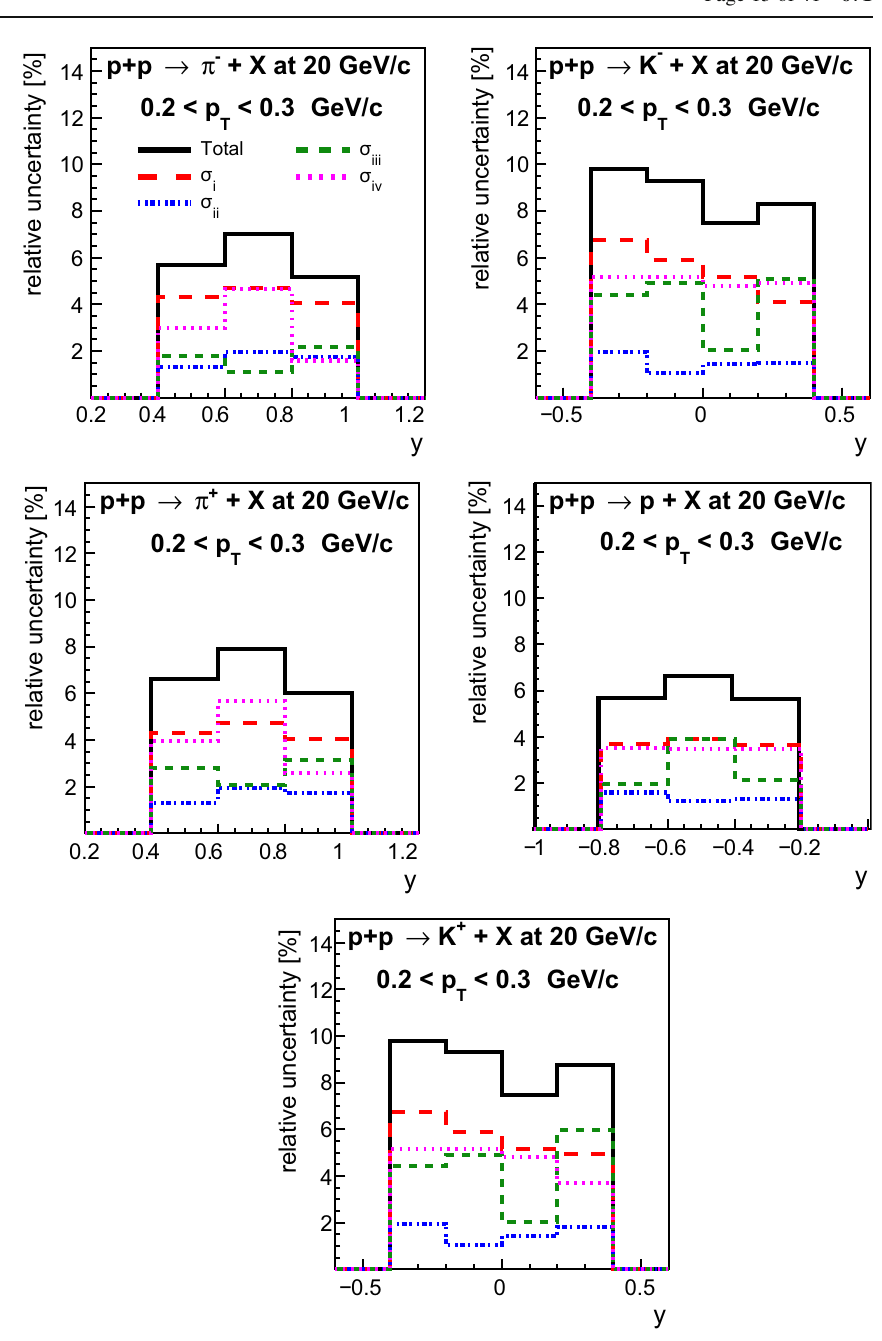
Fig. 18 Components of systematic uncertainty of particle spectra obtained from the tof -d E / d x method in inelastic p + p interaction at 20 GeV / c as function of rapidity for the transverse momentum interval between 0.2–0.3 GeV / c . σ i refers to removal of events with off-time beam tracks, σ ii to possible bias of the S4 trigger, σ iii to event vertex and track selection procedure and σ iv to the identification technique. Black lines (Total) show the total systematic uncertainty calculated as the square root of the sum of squares of the